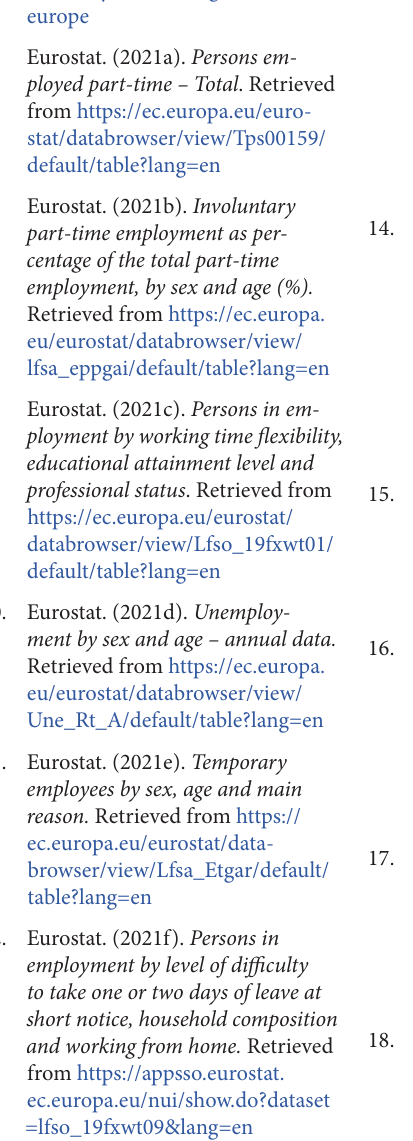
12. Eurostat. (2021f). Persons in employment by level of difficulty to take one or two days of leave at short notice, household